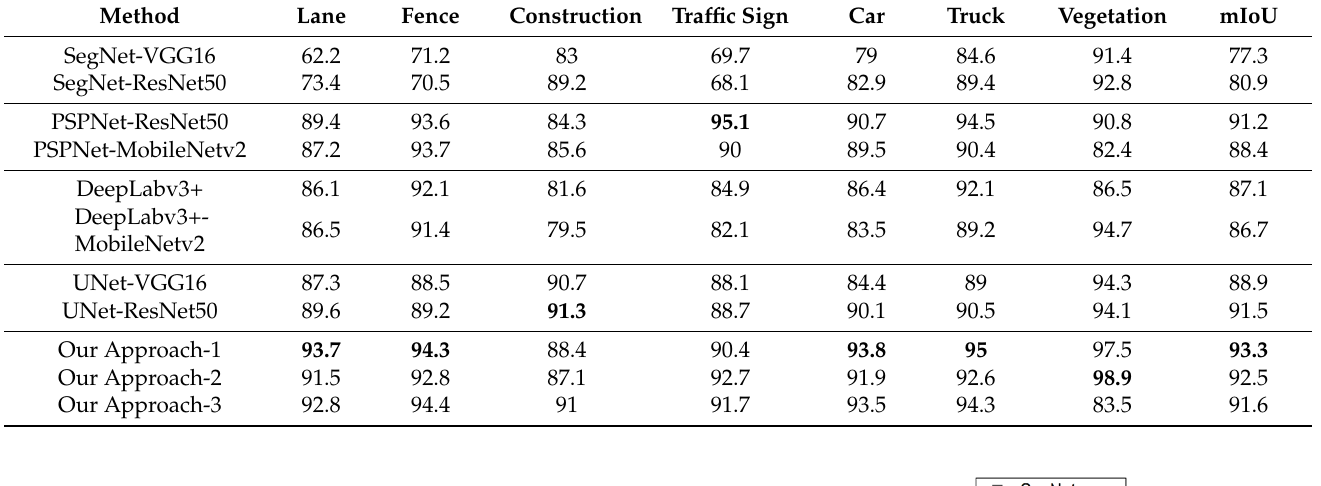
Table 8. Segmentation results of the multi-task model, where bold numbers indicate the highest IoU in each column.